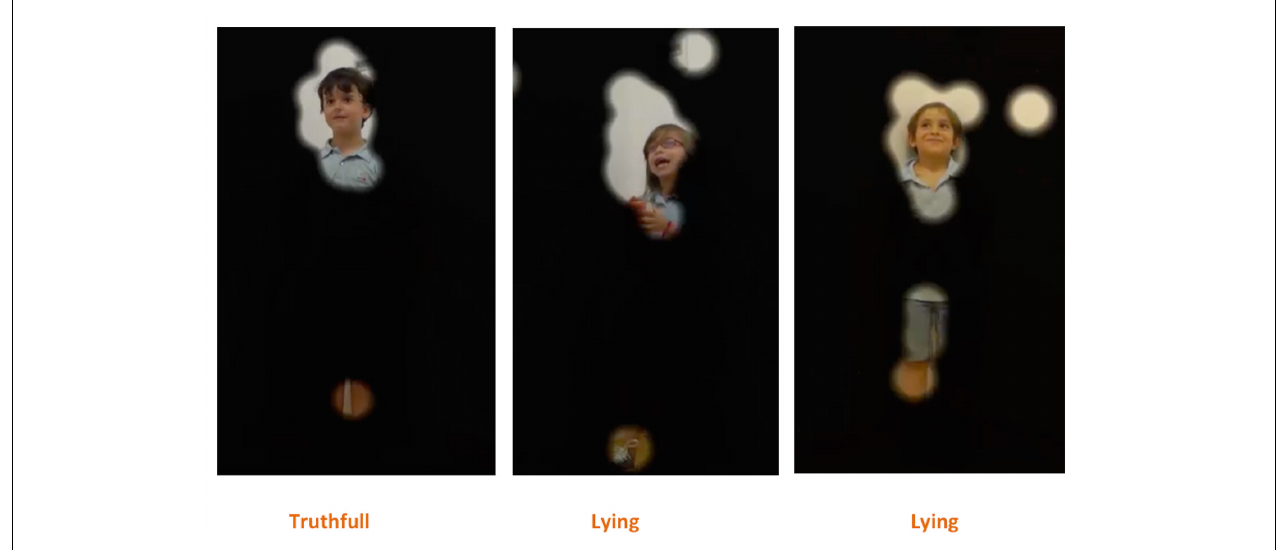
FIGURE 6 | Illustration of a focus map showing the regions (in black) that had fewer fixations by all the judges in each of the three conditions (Tc, Ly1, and